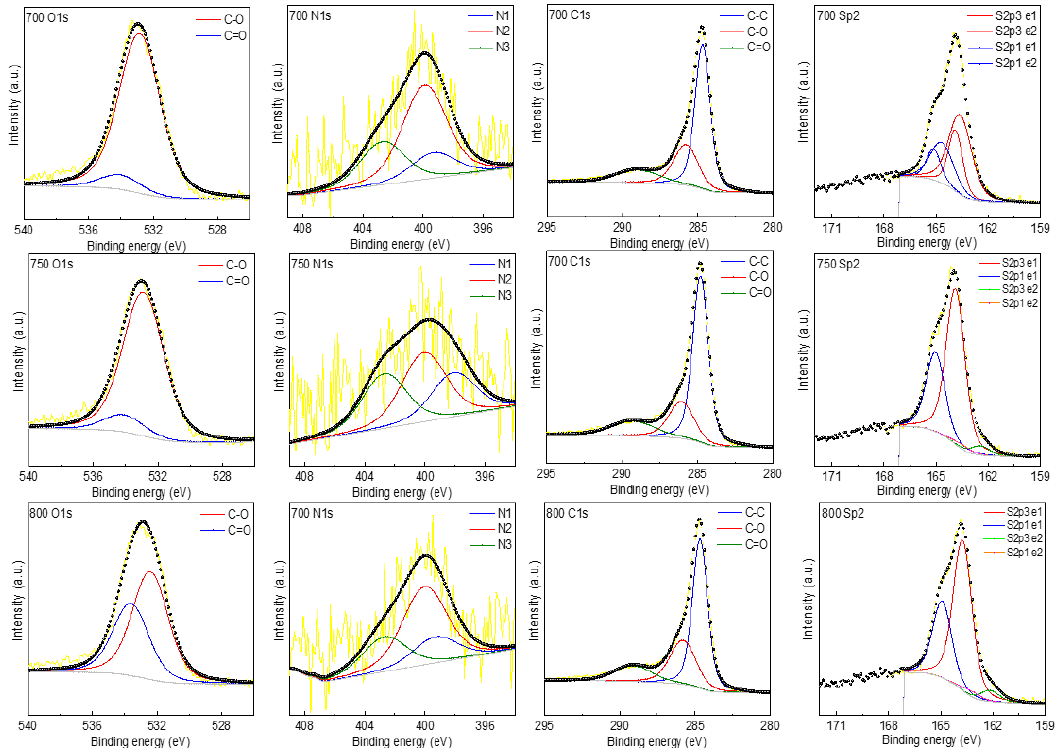
Figure 4. High resolution X-ray photoelectron spectroscopy spectra in the C1s, N1s, and O1s regions for undoped samples (700, 750, and 800).